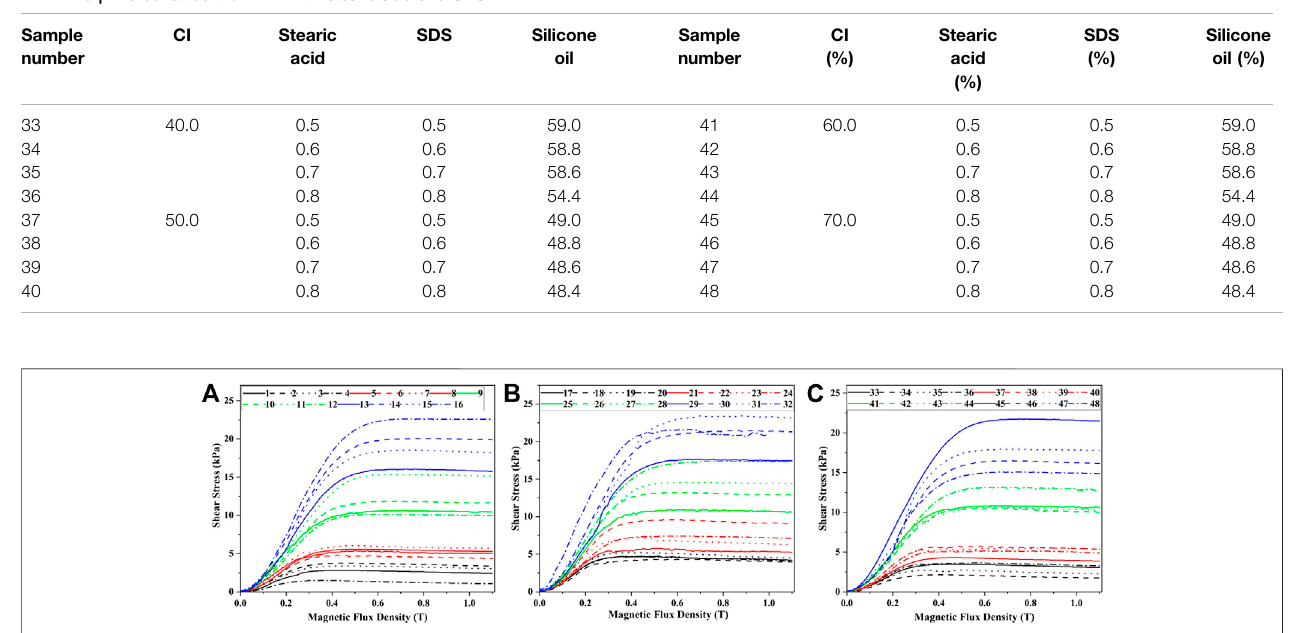
TABLE 3 | The constituent of MRF with stearic acid and SDS.